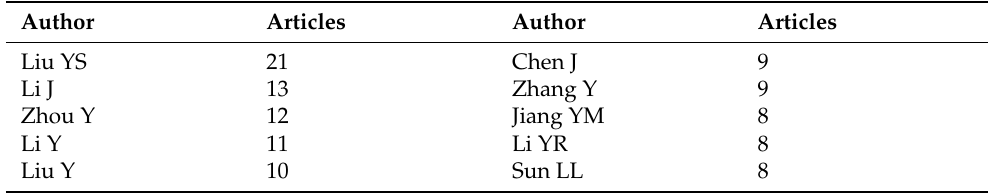
Table 3. Top 10 authors that published articles in the field of rural revitalization from 1991 to 2021 (top